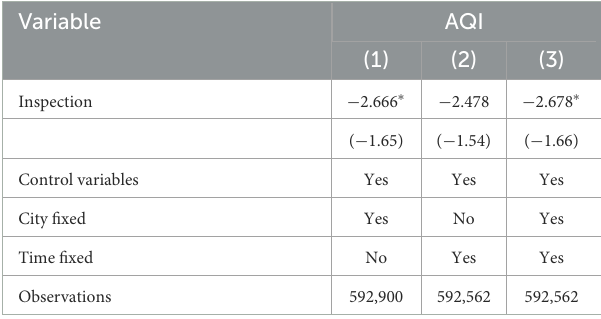
TABLE 4 Baseline results based on the RDD model.